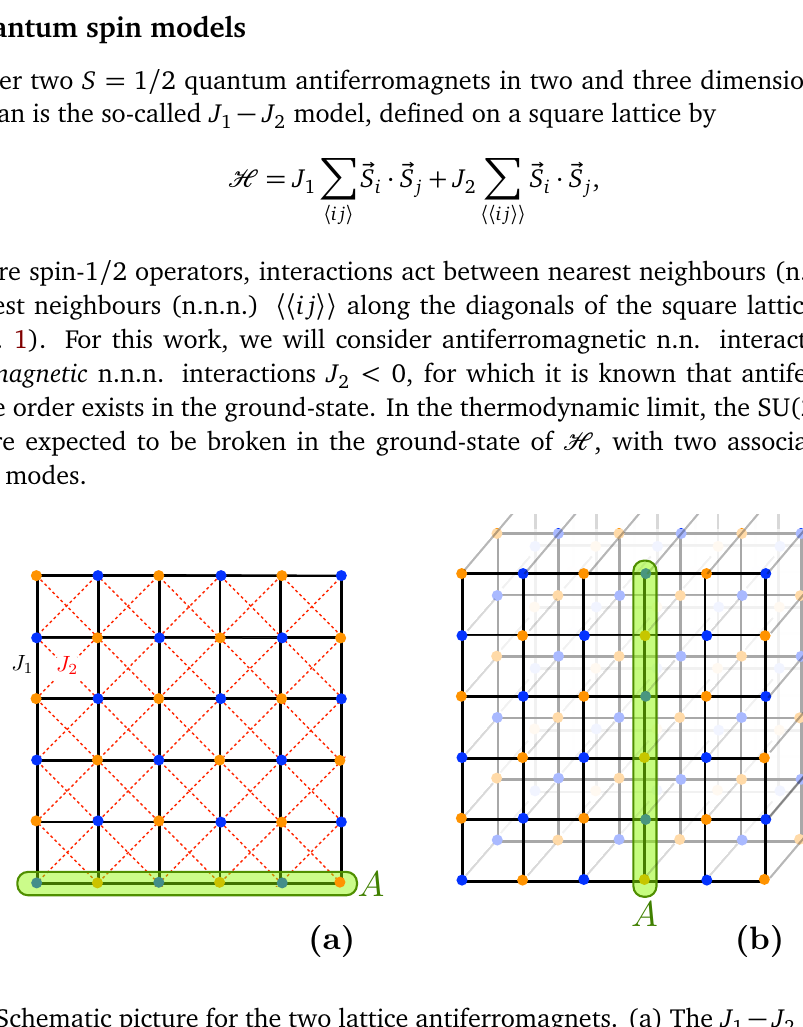
Figure 1: Schematic picture for the two lattice antiferromagnets. (a) The J defined on a two-dimensional square lattice Eq. (2). (b) The nearest-neighbor Heisenberg model Eq. (3) on a three-dimensional cubic lattice. In both cases, the line shaped subsystem A is shown in